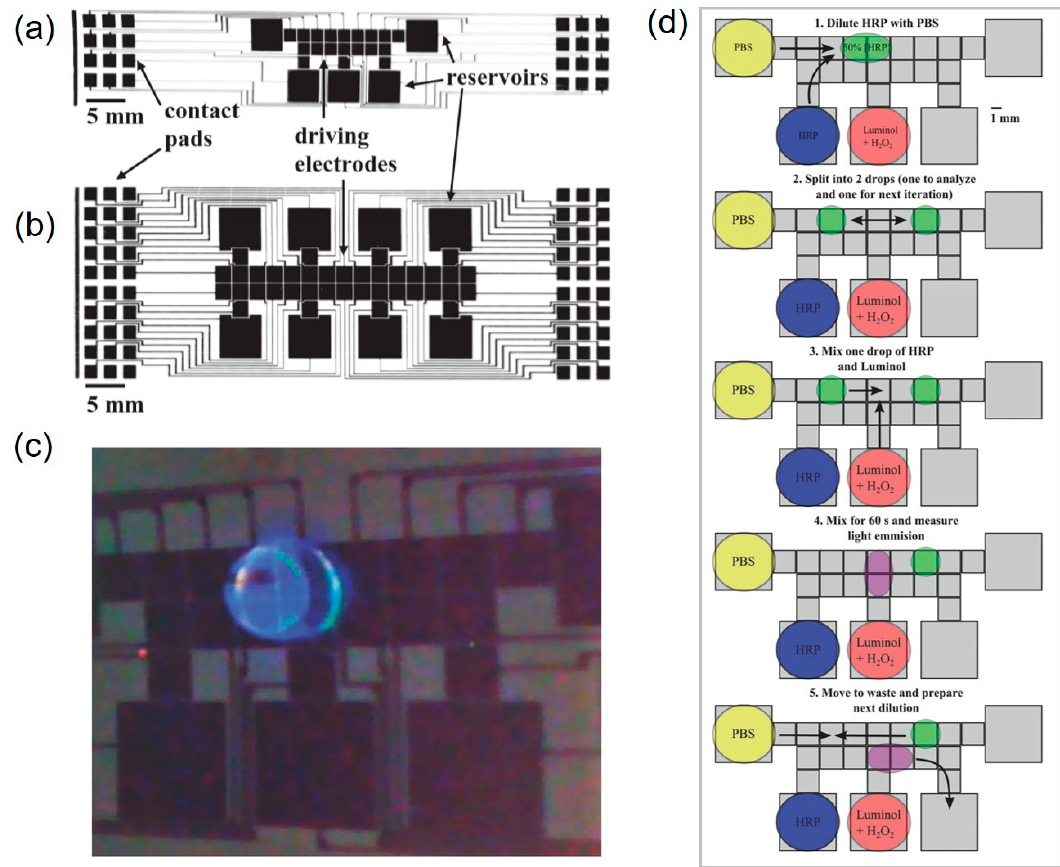
Figure 10. Photographs of p-DMF devices patterned with ( a ) Design A and ( b ) Design B. ( c ) Photograph of a device with its top plate removed for visualization, and ( d ) schematic illustration of the individual steps for homogeneous chemiluminescence assay using a p-DMF device. Reproduced with permission from the authors of [19]. Copyright 2014, WILEY-VCH Verlag GmbH & Co. KGaA,